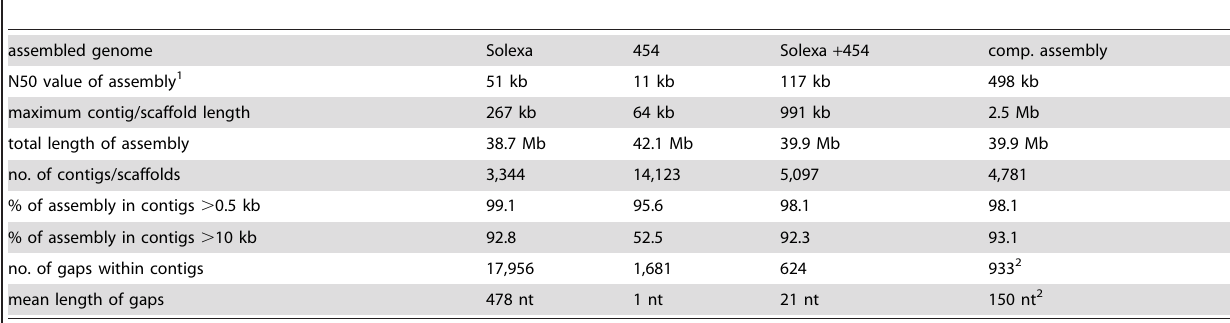
Table 2. Main features of S. macrospora genome assemblies from Solexa reads, 454 reads, a combination of both, and after comparative assembly with the N. crassa